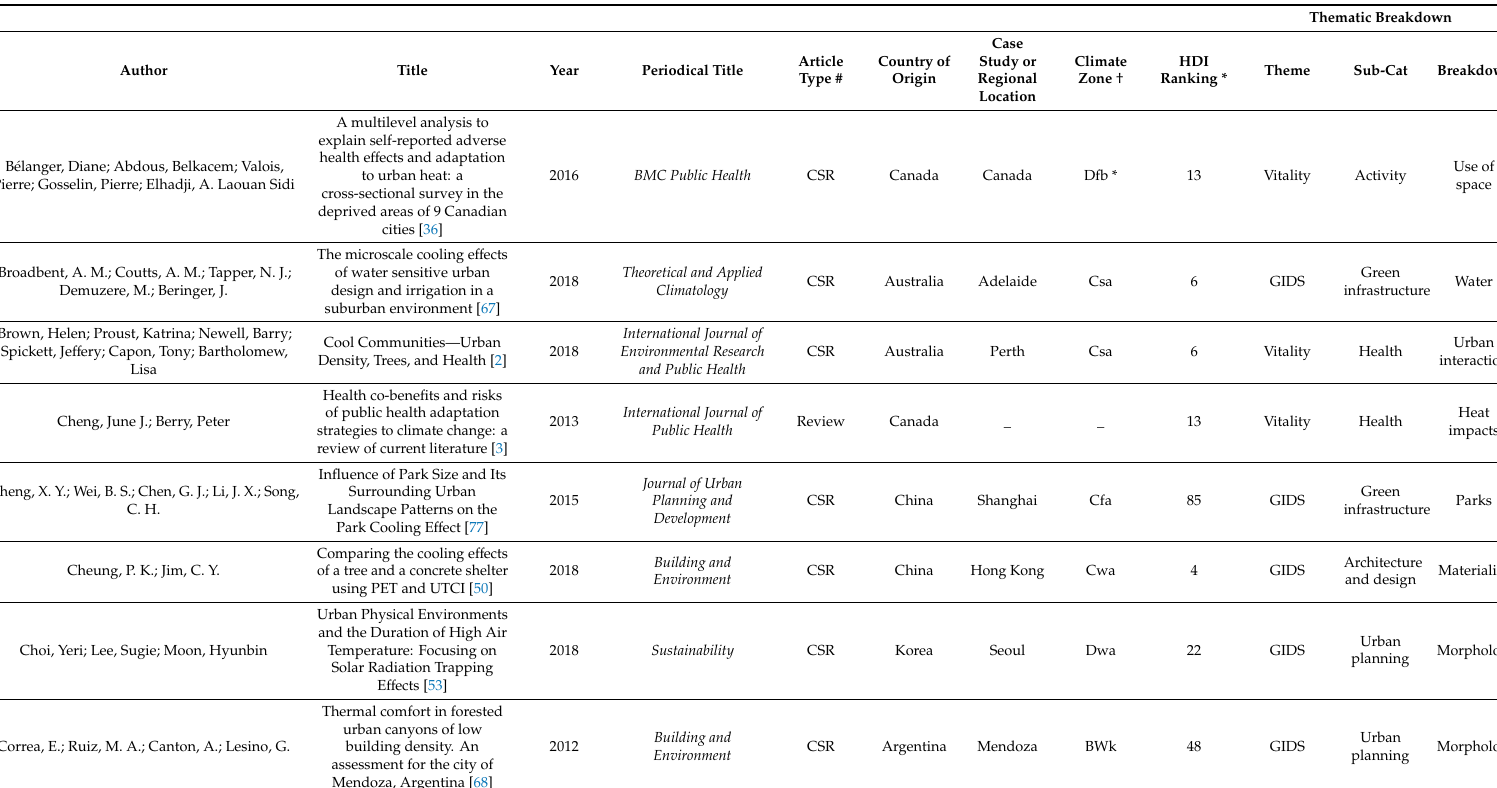
Table A1. Literature included for review, including country of origin, location of connected case study or region presented in the article, climate zone, HDI and thematic